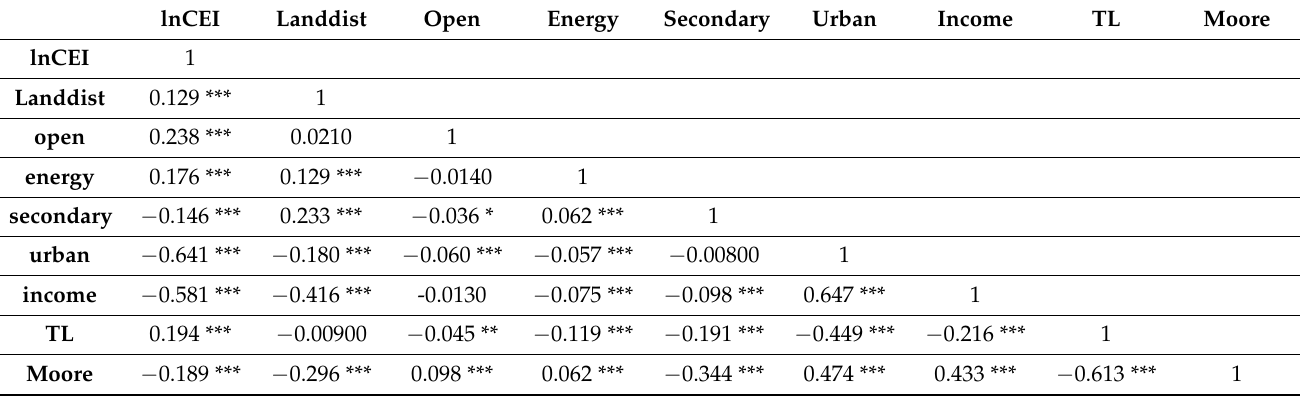
Table 2. Correlation analysis